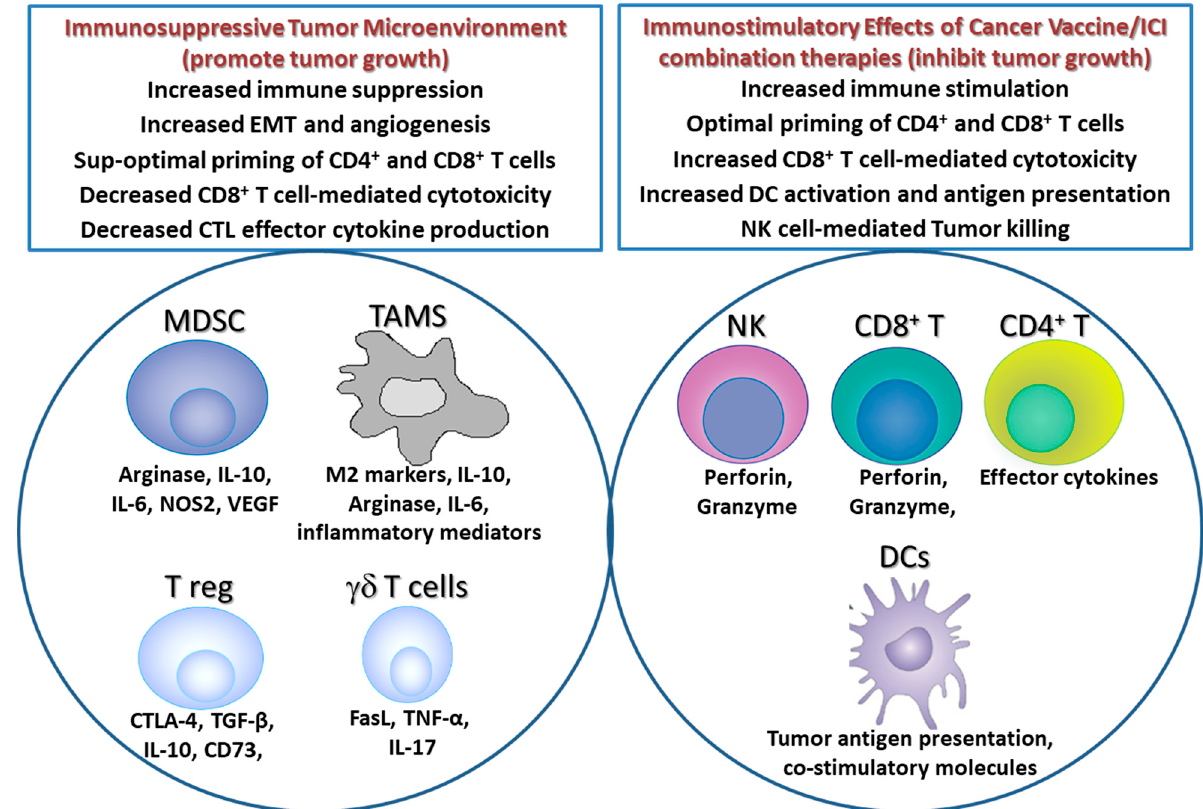
Figure 1. Multiple immune-inhibitory pathways operate within the tumor microenvironment that limit the efficacy of ICIs as well as cancer vaccines. A combinatorial approach consisting of cancer vaccine and ICIs can lead to optimal priming of anti-tumoral immune responses that ultimately orchestrate tumor eradication. The efficacy of this combination approach is somewhat limited by the presence of immunosuppressive cells that accumulate in the tumor microenvironment.